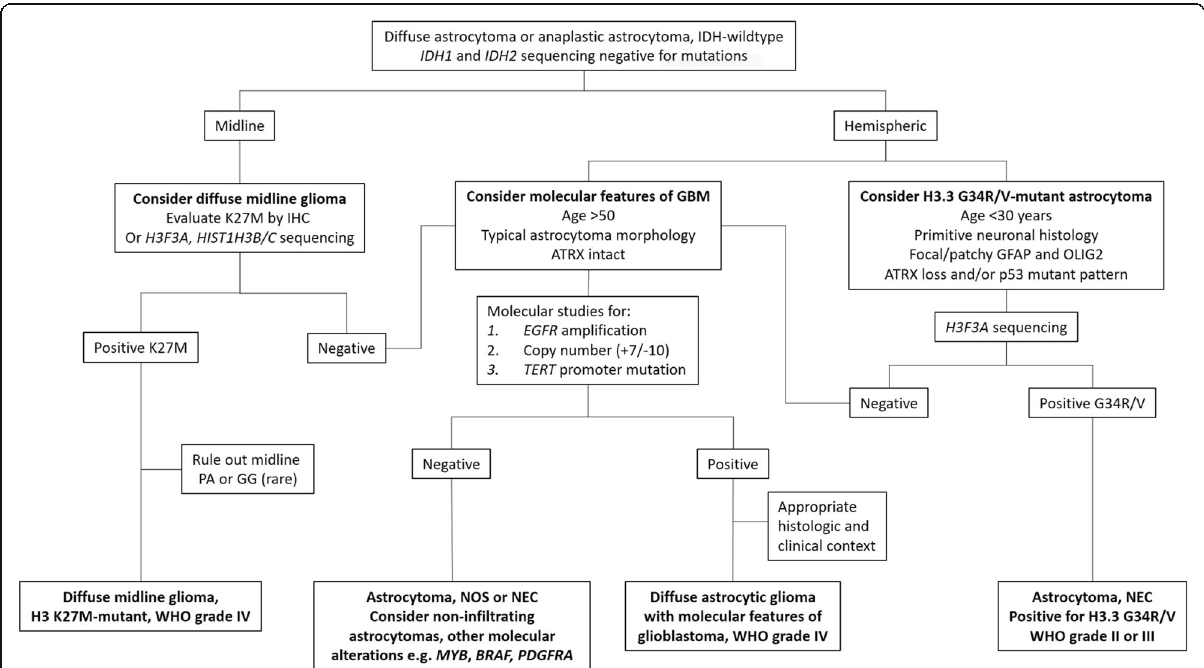
Fig. 6 An approach to IDH-wildtype diffuse astrocytoma and anaplastic astrocytoma. See text for details. Abbreviations: IDH – isocitrate dehydrogenase; IHC – immunohistochemistry; ATRX – ataxia telangiectasia and mental retardation syndrome, X-linked; K27M – histone H3 K27M; G34R/V – histone H3.3 G34R or G34V; PA – pilocytic astrocytoma; GG – ganglioglioma; GBM – glioblastoma; NOS – not otherwise specified; NEC